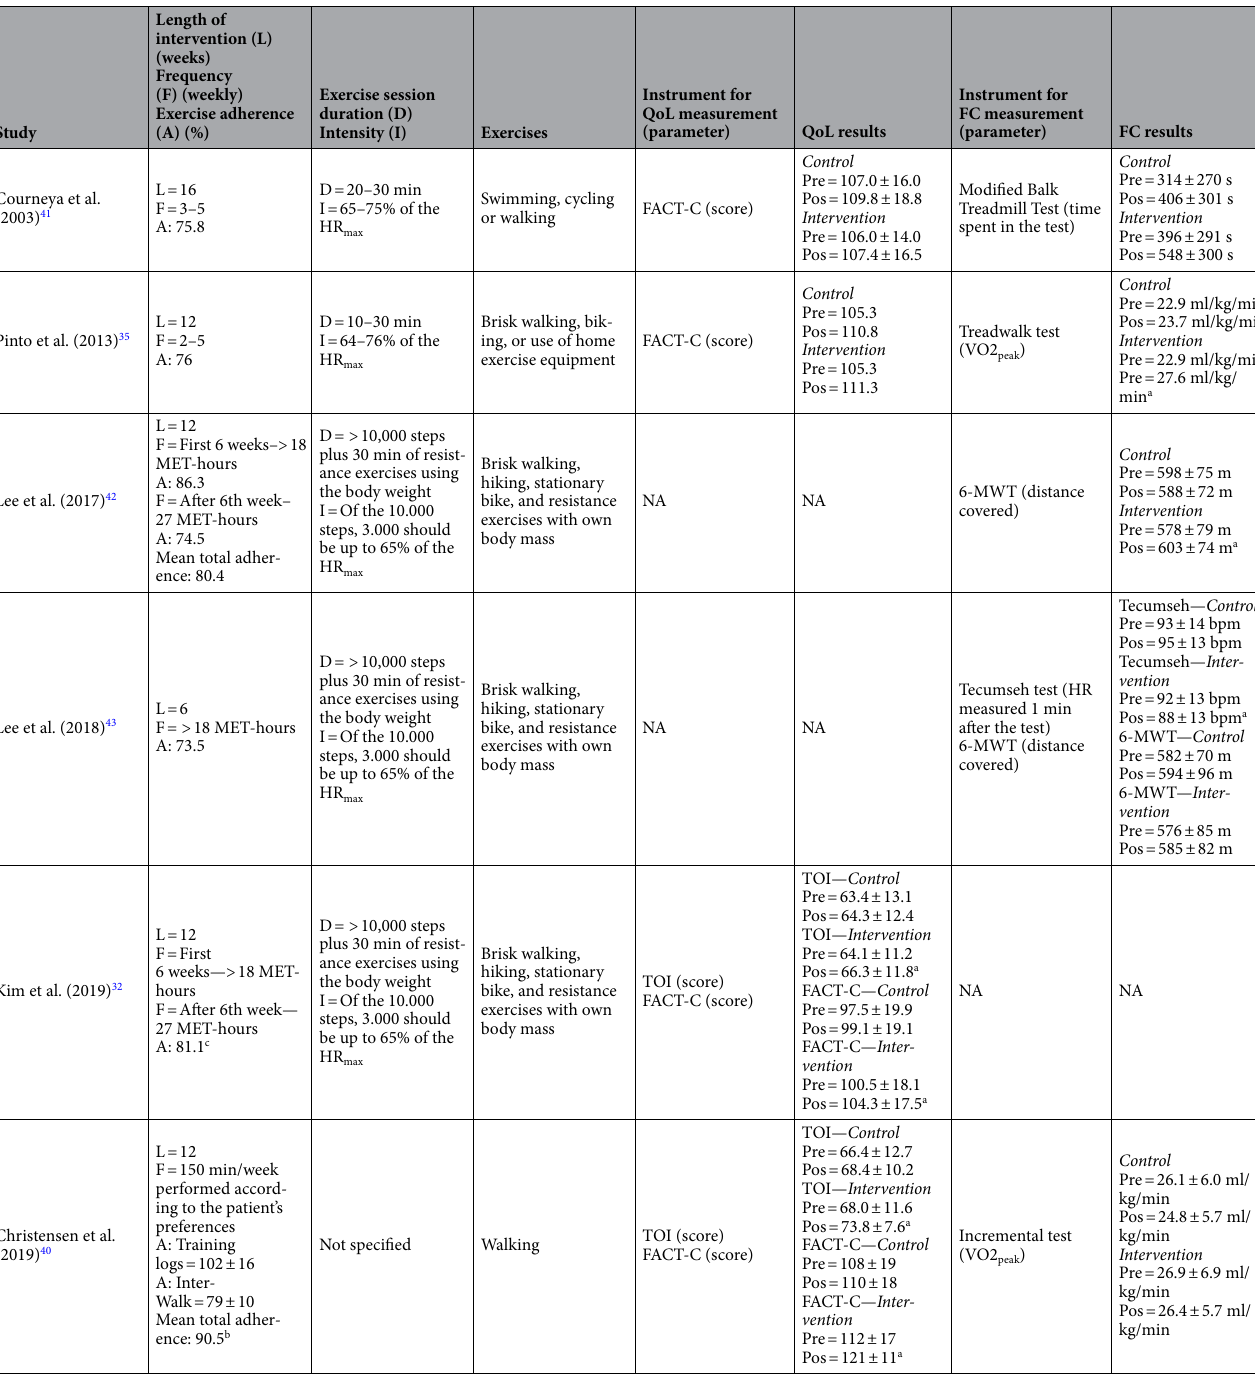
Table 3. Studies design and Quality of Life (QoL) and Functional Capacity (FC) outcomes of home-based exercise interventions in colorectal patients. HRmax maximum heart rate, FACT-C functional assessment of cancer therapy-colorectal, VO2 peak peak oxygen uptake, 6-MWT 6 Minute Walk Test, TOI-PEC trial outcome index-physical/functional/colorectal. a Denote difference from Pre. b The adherence was obtained by training logs and an application named InterWalk. c Retention